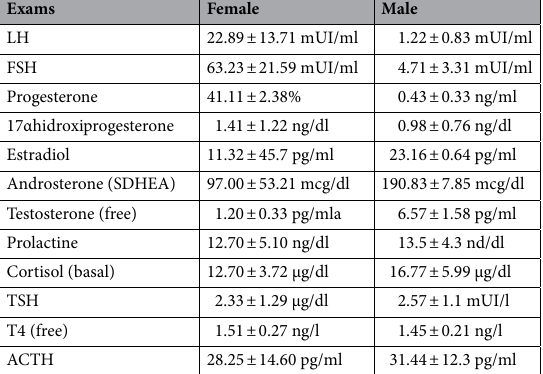
Table 5. Comparative analysis of female and male hormone levels (mean ± standard deviation of mean) after splenectomy. LH luteinizing hormone, FSH follicle stimulating hormone, TSH thyroid stimulating hormone, T4 thyroxine, ACTH adrenocorticotropic hormone and